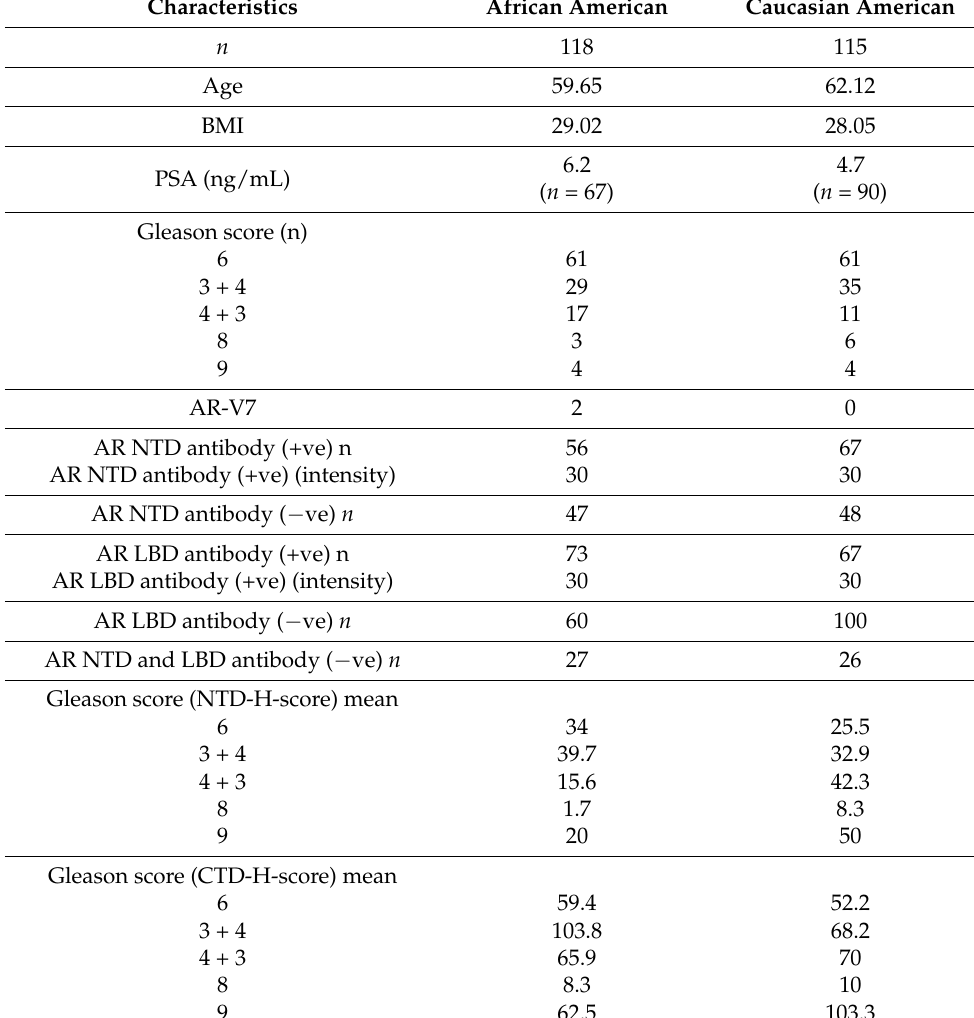
Table 1. Patient demographics and specimen